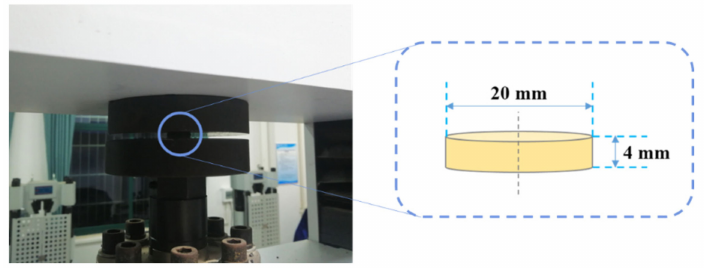
Figure 2. The quasi-static experimental device and the dimensions of each